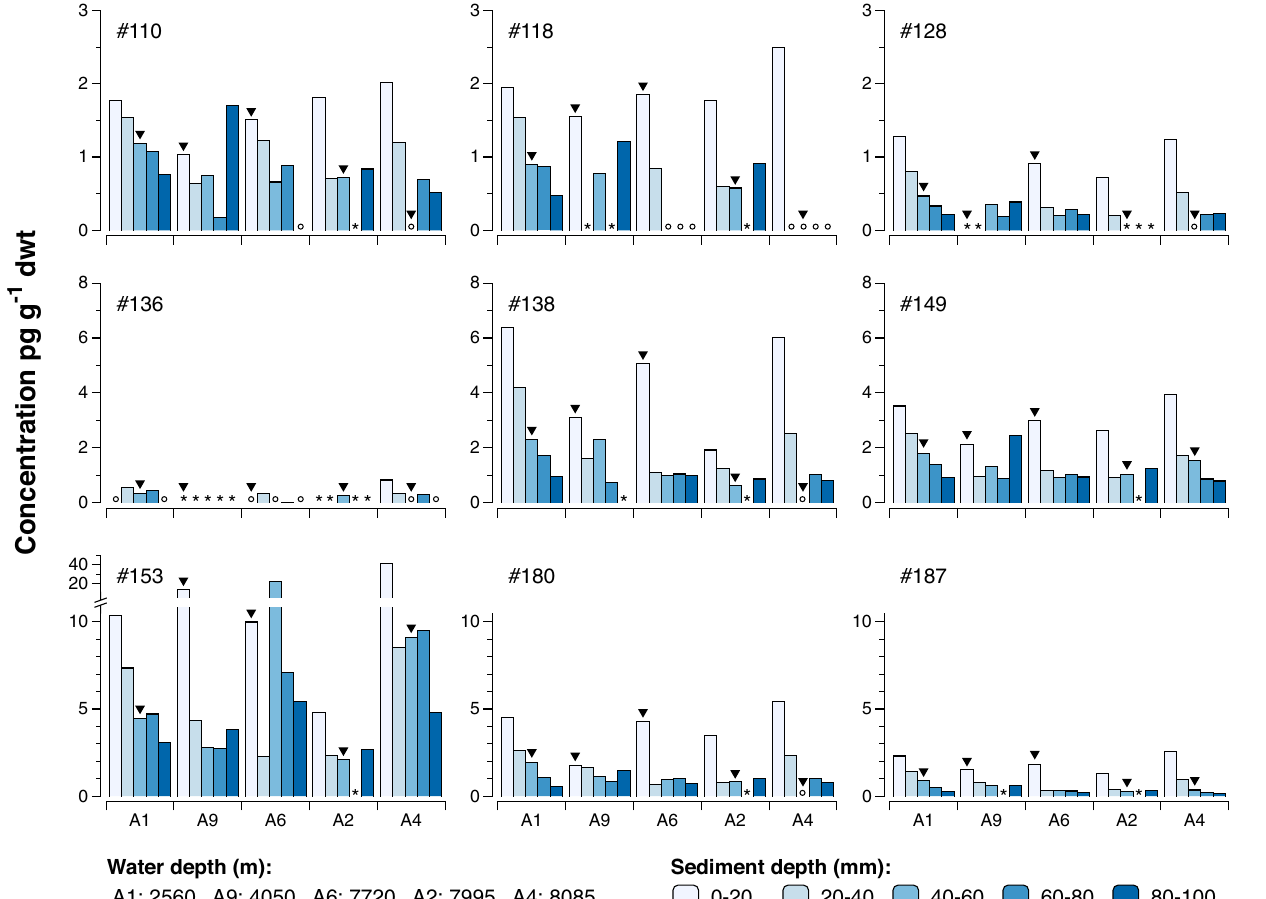
Fig.2|Concentrations(givenaspgcontaminantpergofdrysediment)ofnine polychlorinated biphenyl (PCB) congeners in the fi ve upper sediment layers collectedintheAtacamatrencharea(A1-A9). Asterisksandcirclesindicatepeaks cannot be integrated and concentrations below detection limit, respectively.